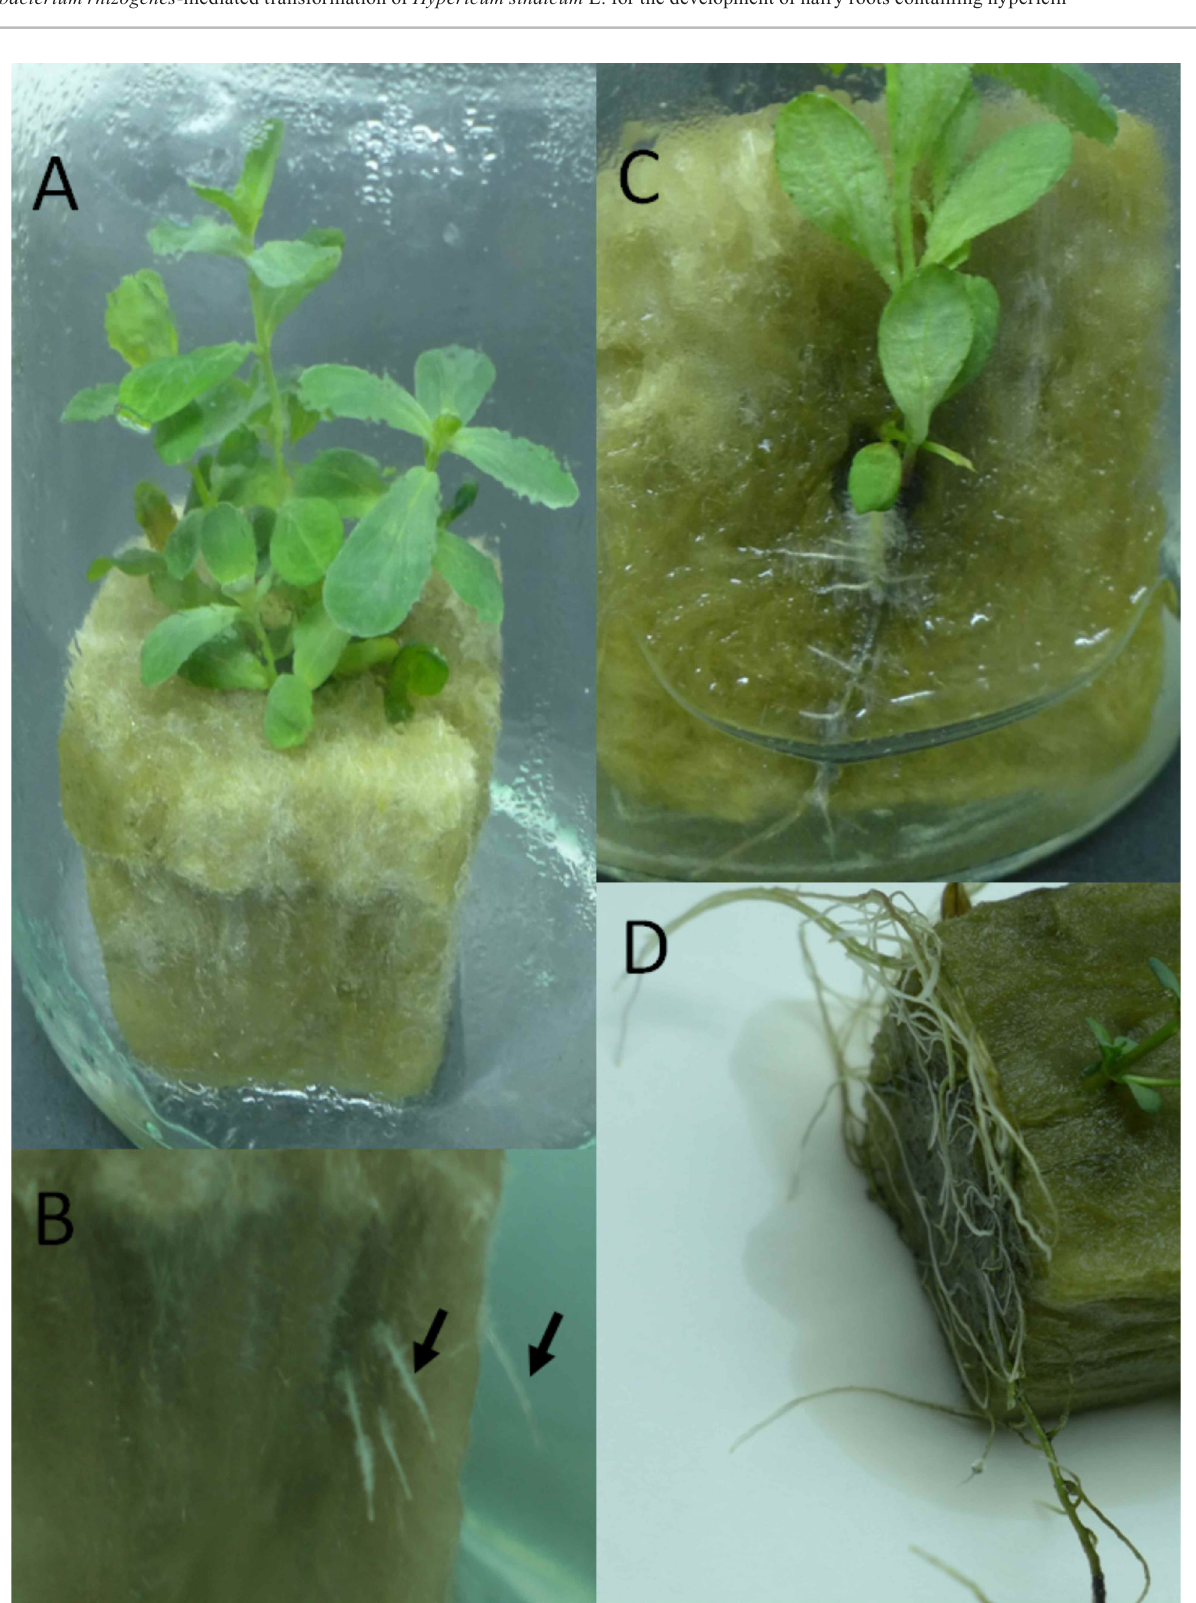
FIGURE 5 - Hairy root development on H. sinaicum shoots held in Rockwool cubes in vitro and inoculated with the A4 A. rhizogenes strain. Control shoots after a six-week-culture (A), hairy roots appearing at Rockwool cube sides 10 days after inoculation (B), branched hairy root (C), Rockwool cube overgrown by hairy roots three weeks after shoot inoculation